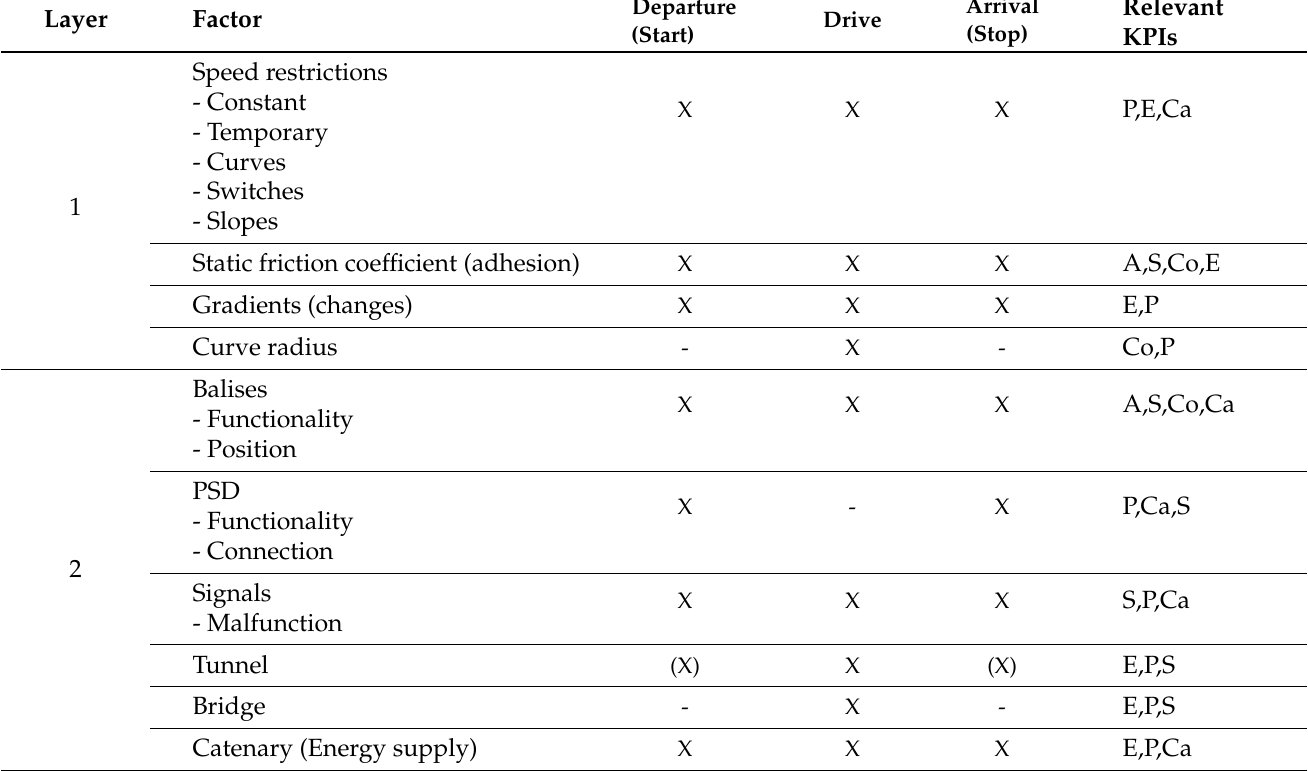
Table A1. Overview of all factors capable of influencing the performance of an ATO system and especially the ATO algorithm. Factors are structured by the layers of the layer model of the railway sector and provide information about the operational phase they are relevant to. Relevant Arrival Departure Drive (Stop) (Start)